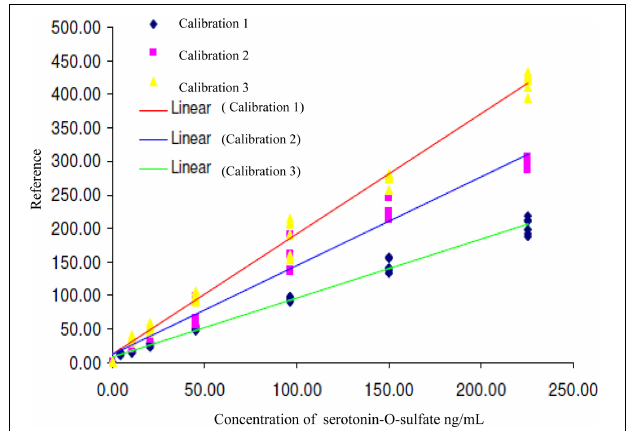
FIGURE 3 | Calibration lines of 5-HT-SO4 during three different days of analysis. The concentration of 5-HT-SO4 in the plasma samples is given prior to treatment. For the Calibration 1 concentration range was 4.4–225.2ng/mL, for the Calibration 2 and 3 the range was